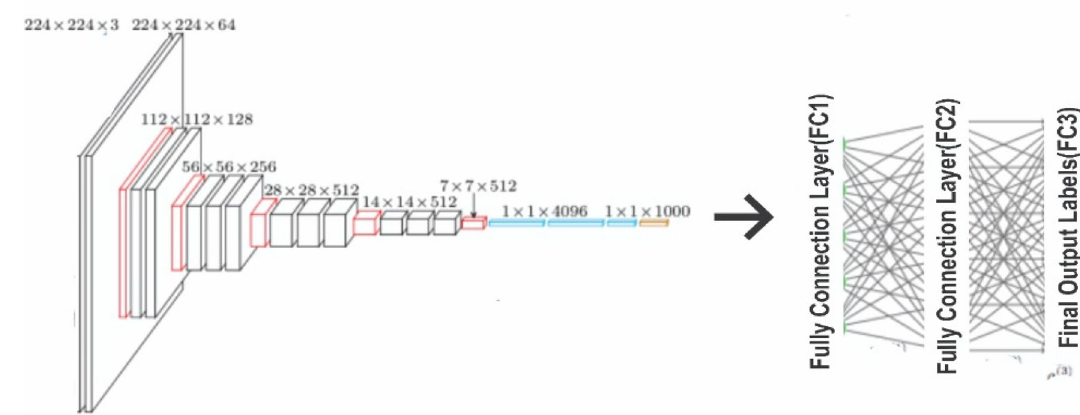
Fig. 2 VGG 16-Layers